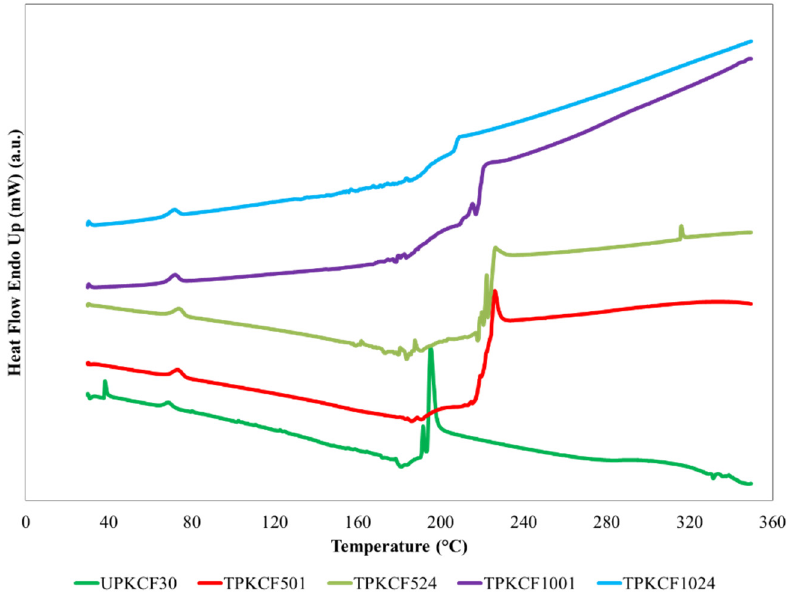
Figure 13. DSC thermogram of untreated and treated PKCF/ER